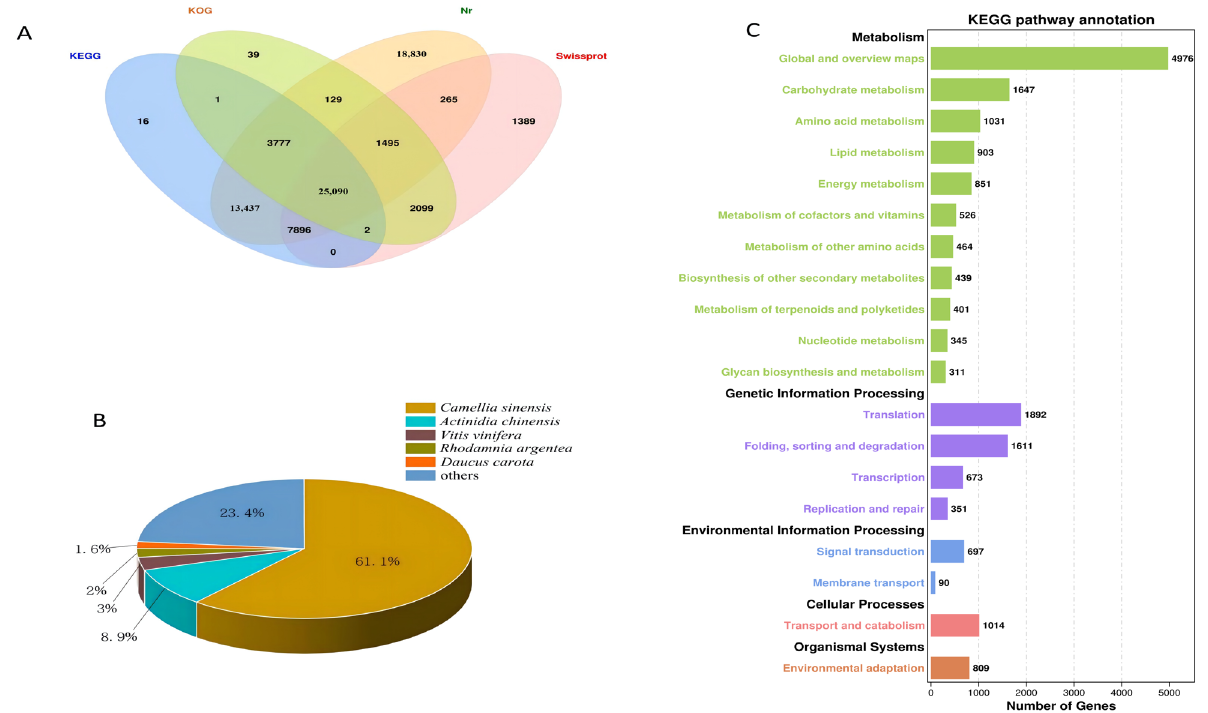
Figure 3. ( A ): Venn diagram annotated using four datasets. ( B ): Species distribution for all unigenes in the transcriptome in NR. ( C ): KEGG pathway classification.